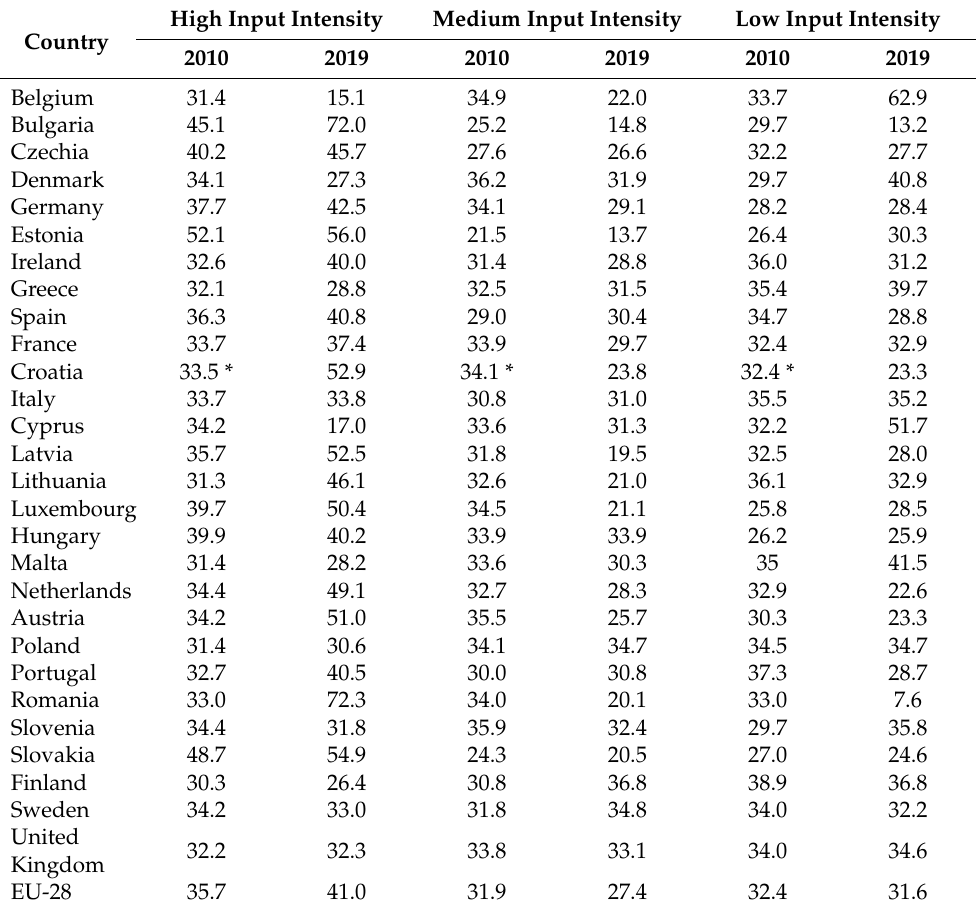
Table 2. The structure of utilized agricultural area managed by agricultural holdings according to the intensity of production inputs in the member states of the EU in 2010 and 2019